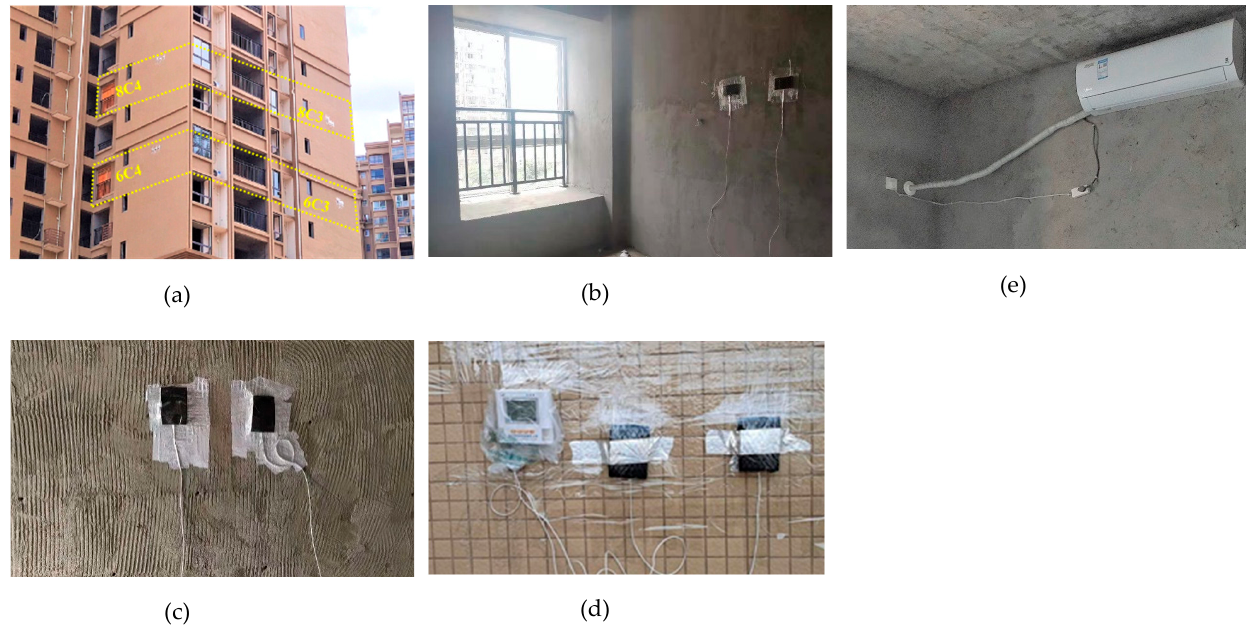
Figure 3. Locations of the tested rooms and measurement points for the wall temperature ( T w ), indoor air temperature ( T a _in), and relative humidity ( Rh_in ). Unit of dimensions in the figure is millimeter (mm).